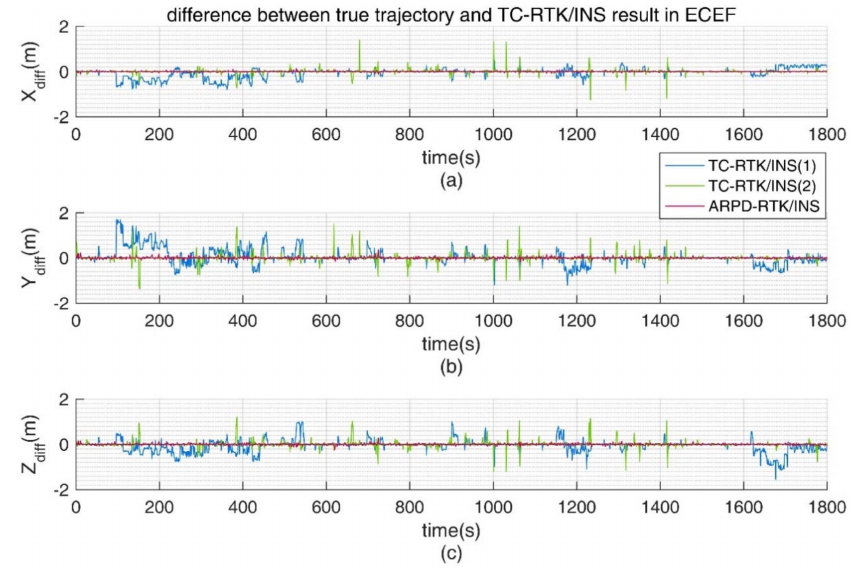
Figure 12. ( a ) Error distribution in Earth-Centered Earth-Fixed (ECEF)-XYZ axis for different algorithms; ( b ) Error distribution in ECEF-Y axis; ( c ) Error distribution in ECEF-Z